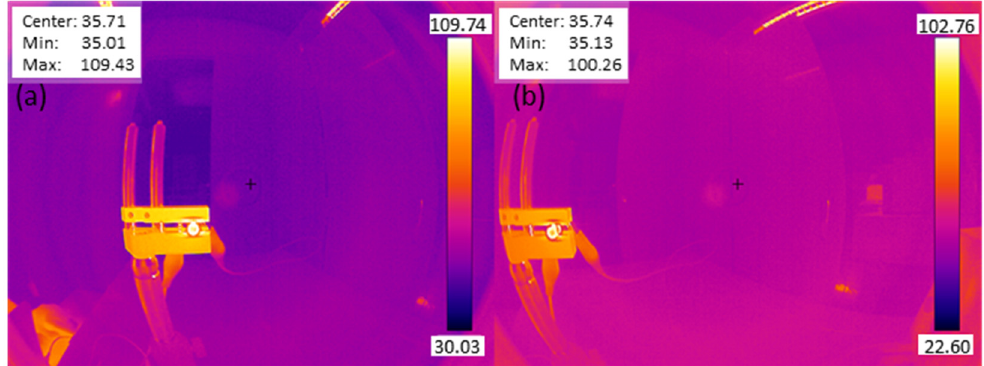
Figure 10. Thermal image of a mounted LED, heating up a metal plate: ( a ) on-axis positioning, ( b ) off-axis (at 164°) positioning.